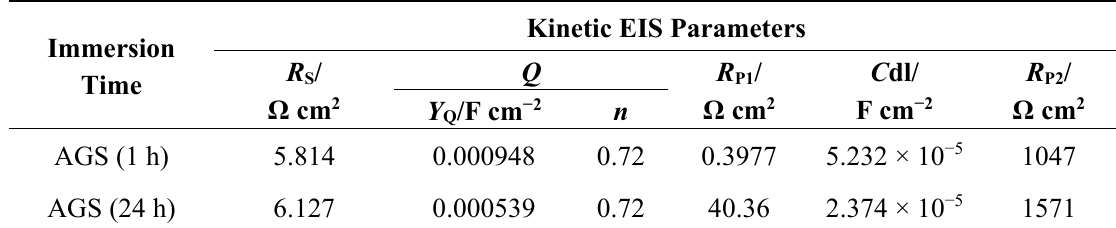
Figure 6. The equivalent circuit model used to the fit the EIS data shown in Figure 5; the symbols of the equivalent circuit are defined in the text and the values are listed in Table 2. Table 2. Parameters obtained by fitting the EIS data shown in Figure 5 with the equivalent circuit shown in Figure 6 for the electrode after its immersion for 1 h and 24 h in